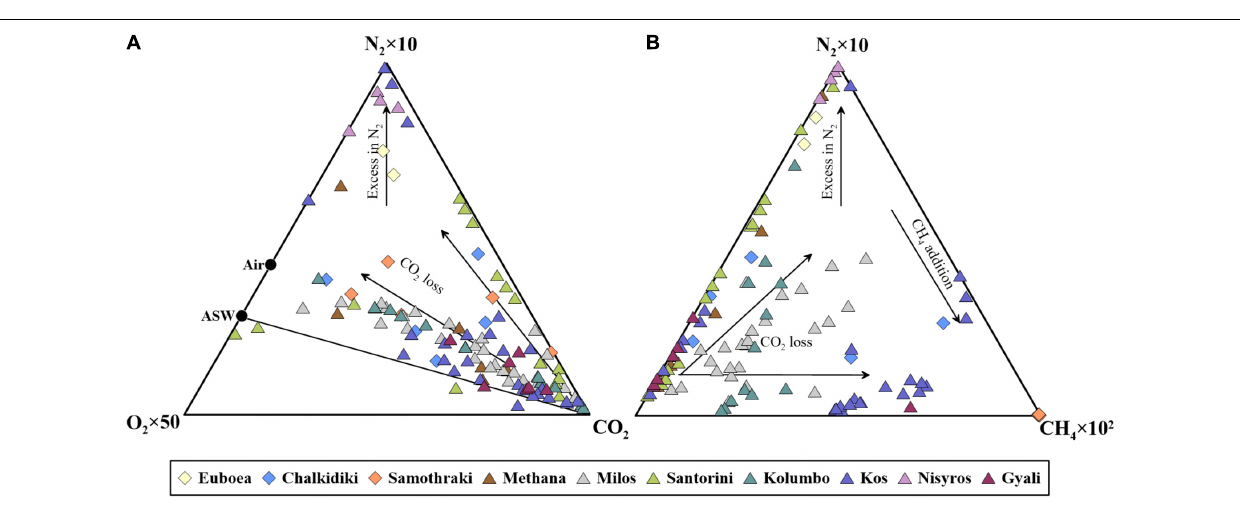
FIGURE 6 | Ternary plot of (A) CO 2 -N 2 -O 2 and (B) CH 4 -N 2 -CO 2 . Processes impacting the gases are drawn with an arrow. The abbreviation “ASW” stands for air saturated water. Values of air and air saturated water (ASW) after Kipfer et al. (2002). Literature data from Chiodini et al. (1998), Shimizu et al. (2005), Kyriakopoulos (2010), Carey et al. (2013), Tassi et al. (2013), Rizzo et al. (2016, 2019), Daskalopoulou et al. (2018a,b, 2019b, 2021a), and Tarchini et al.